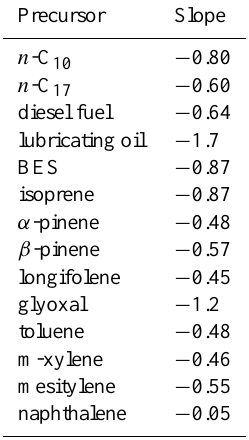
Table 1. f 44 and f 43 for PAM-generated SOA/OPOA. Column 1 lists SOA/OPOA precursor, and “maxOH” and “minOH” denote measurements at the maximum ( ∼ 2 × 10 12 moleccm − 3 s) and min-